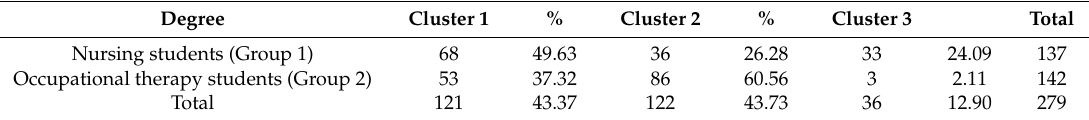
Table 4. Contingency table between students in the two grades and the distribution in the clusters.